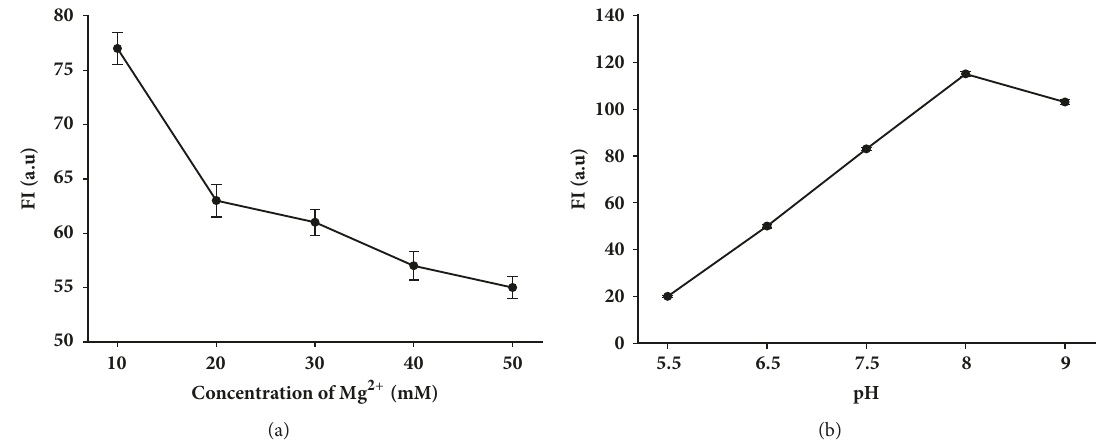
Figure 2: Effects of Mg 2+ (a) and pH value (b) on the hybridization between miR21-MB and miR21.